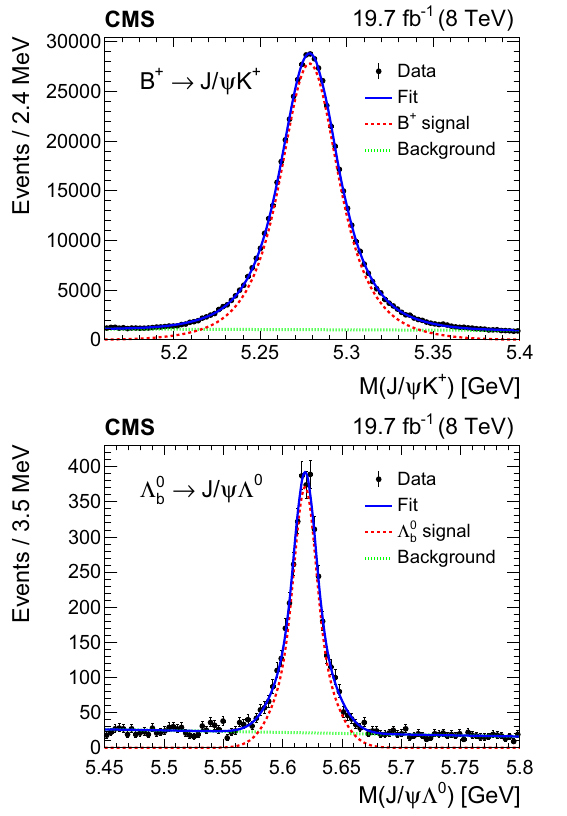
Fig. 2 Invariant mass (left) and ct (right) distributions for B + (upper) andfor Λ 0 (lower)candidates.Thecurvesareprojectionsofthefittothe b data, with the contributions from signal (dashed), background (dotted), and the sum of signal and background (solid) shown. the lower panels